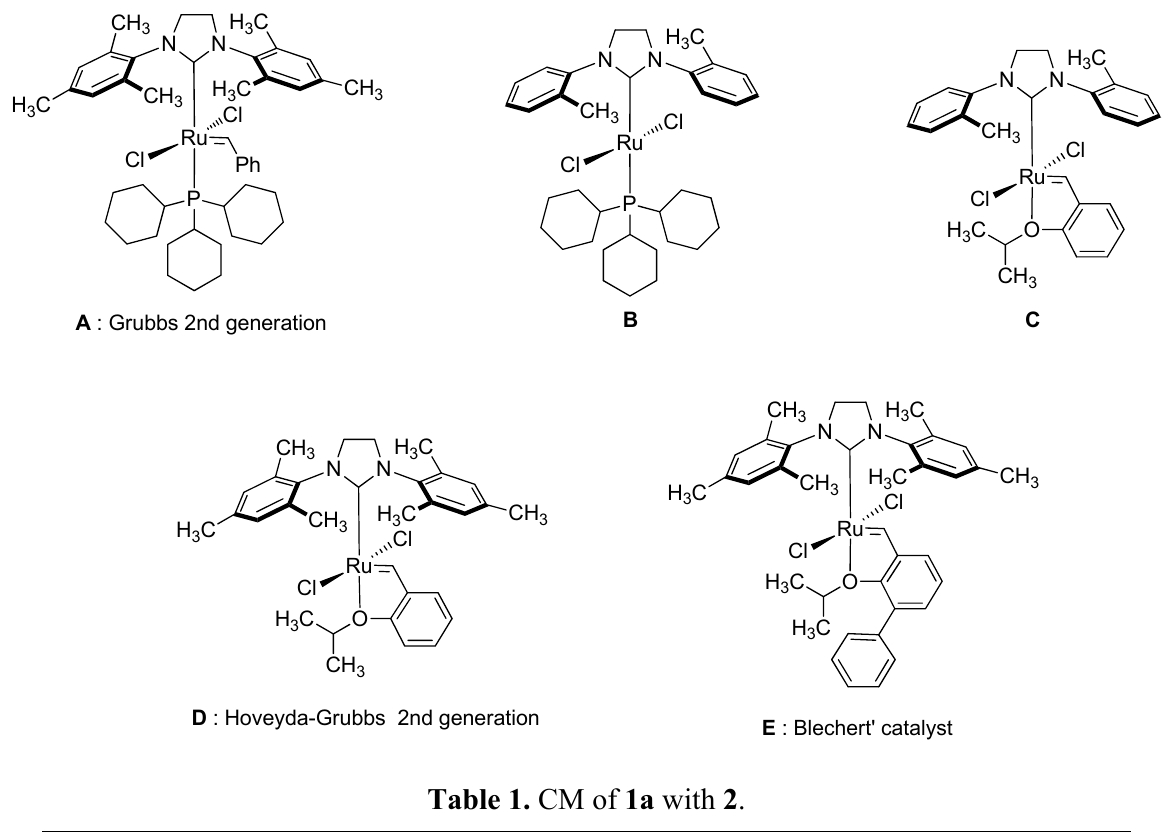
Figure 2. Catalysts for cross metathesis.